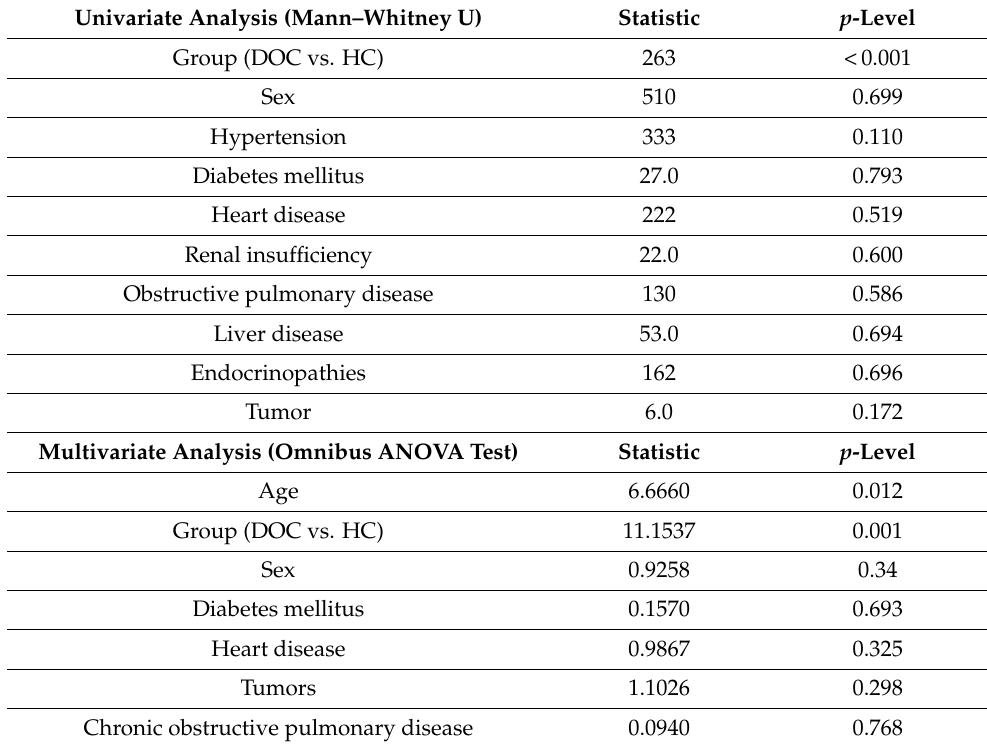
Table 3. Univariate and multivariate analyses to evaluate the factors influencing the decline in antibody responses at 6 months from